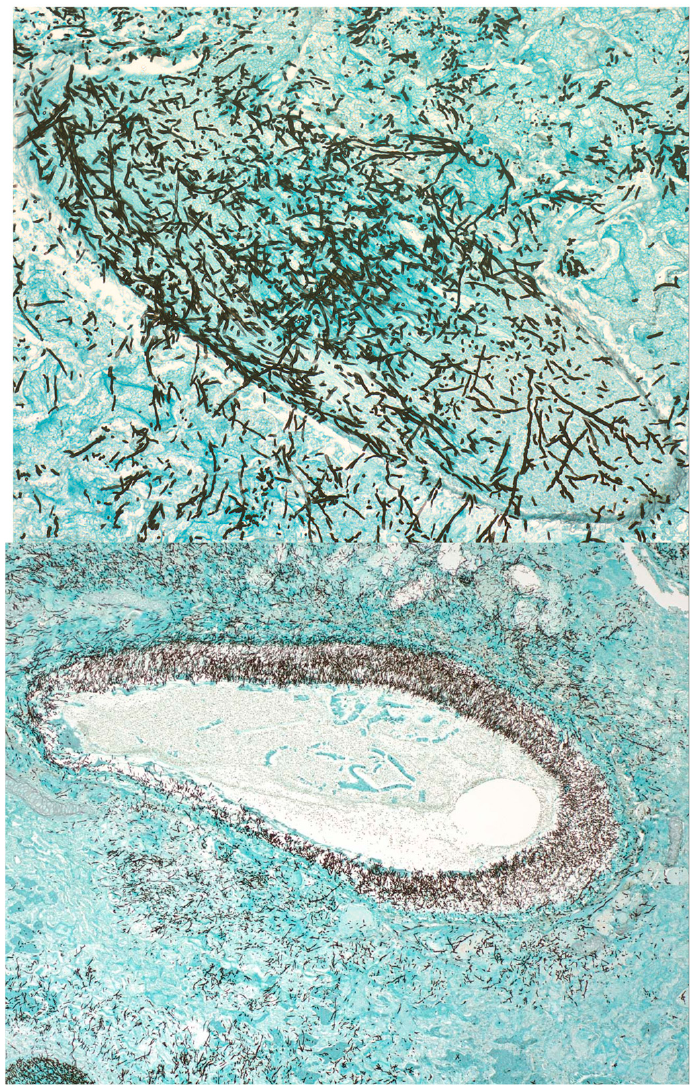
Figure 3. Histopathology of experimental pulmonary aspergillosis in the persistently neutropenic rabbit model depicts dichotomously branching septated hyphae of Aspergillus fumigatus invading blood vessels with thrombosis and extension into adjacent alveolar tissue (Grocott-Gomori’s methenamine silver (GMS) stain; original magnifications: upper panel (200×); lower panel (40×)).